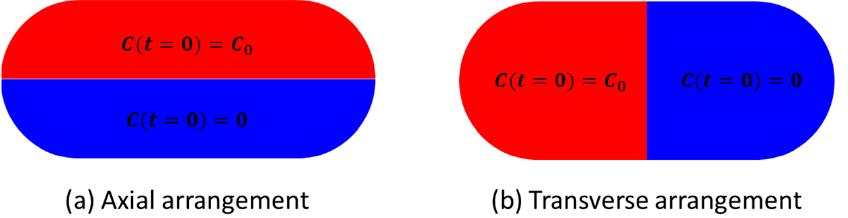
Figure 6. Flow diagram for the iteration process towards quasi-steady-state of the flow solution. ( a ) Axial arrangement; ( b ) Transverse